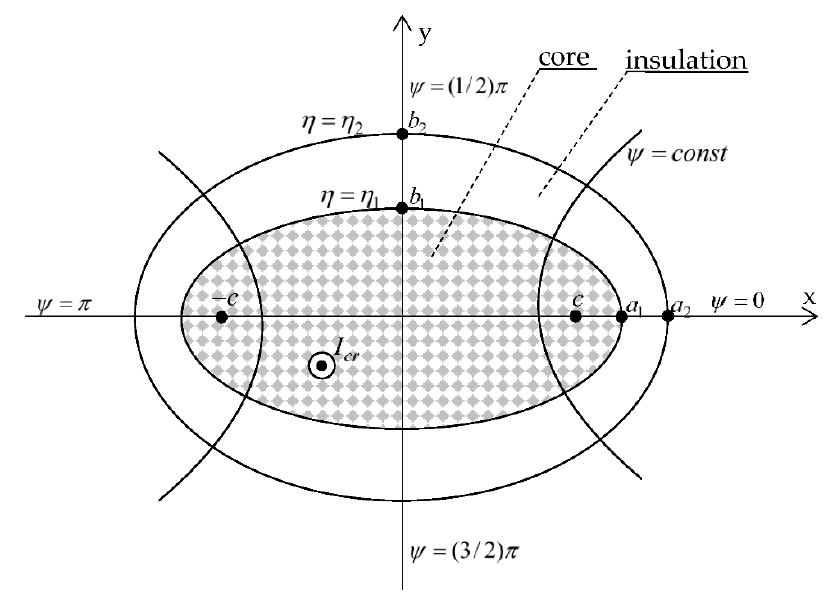
Figure 1. The cross-section of the elliptical conductor in the elliptic and Cartesian coordinate systems.